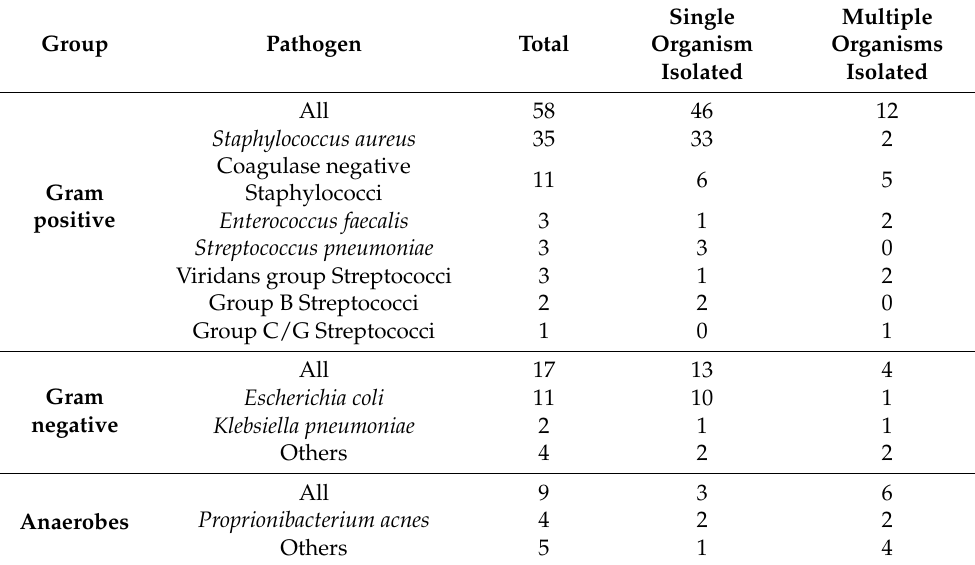
Table 1. Bacteria isolated from patients with